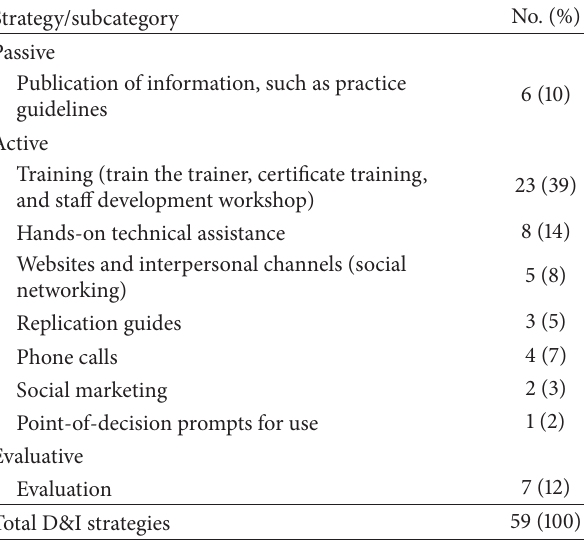
Table 4: Passive, active, and evaluative D&I strategies identified.